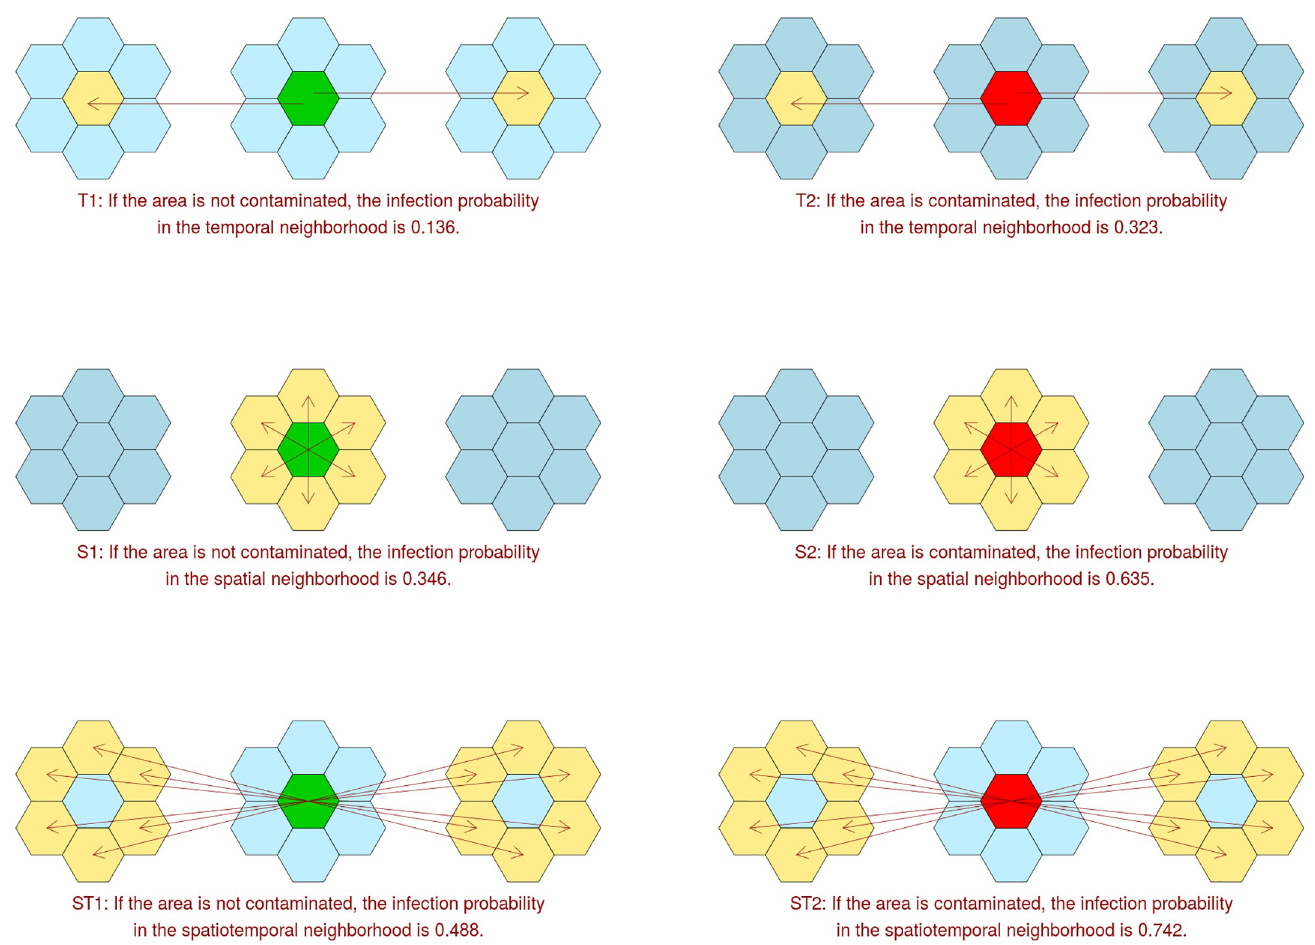
Fig 2. Correlations of areas with and without